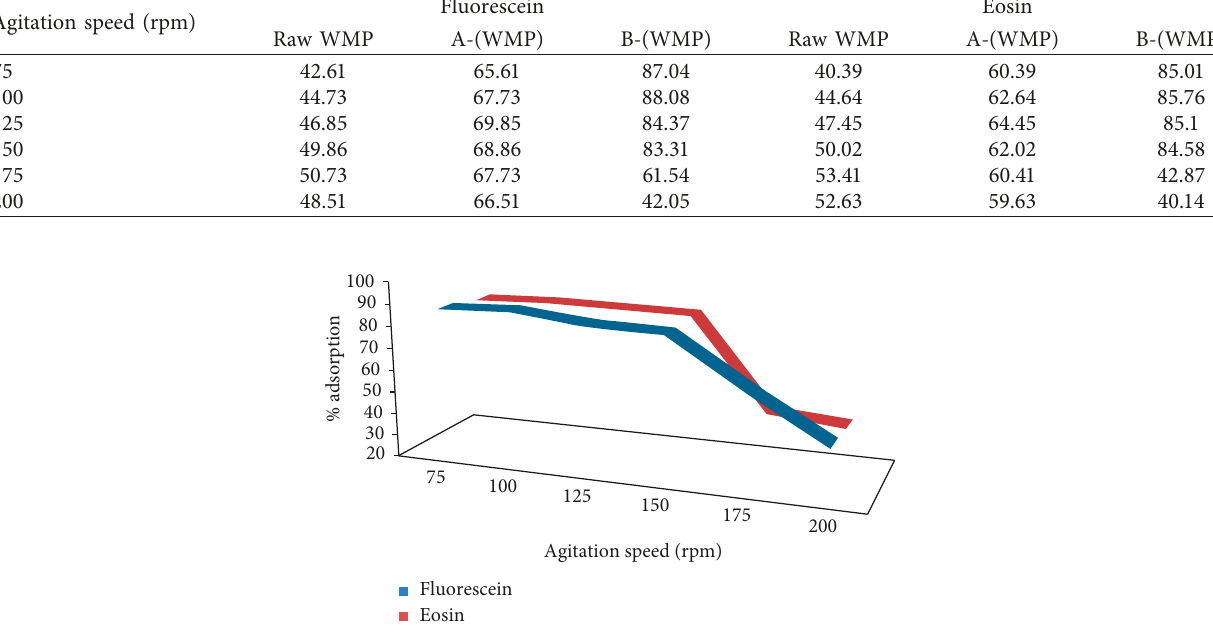
Figure 6: Comparative sorption efficiency of the base-treated WMP at different agitation speeds for removing fluorescein and eosin dyes. Table 5: Adsorption rate of the sorbent material (WMP) at varying